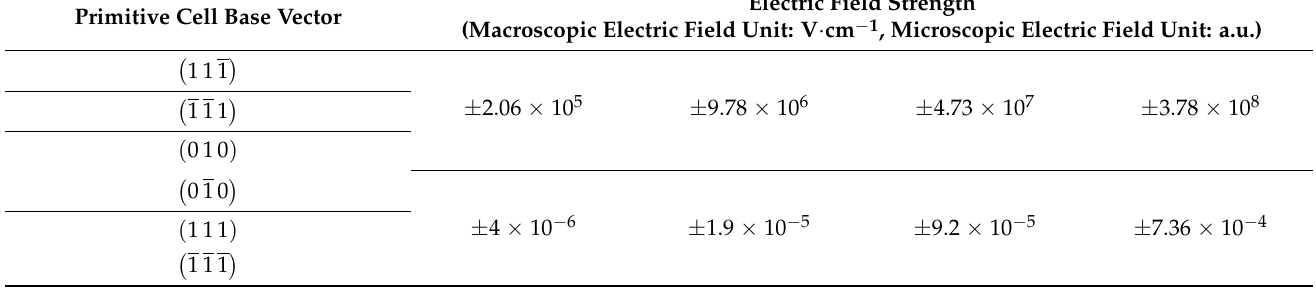
Table 1. The direction and magnitude of the electric field applied by the diamond when calculating the phonon dispersion